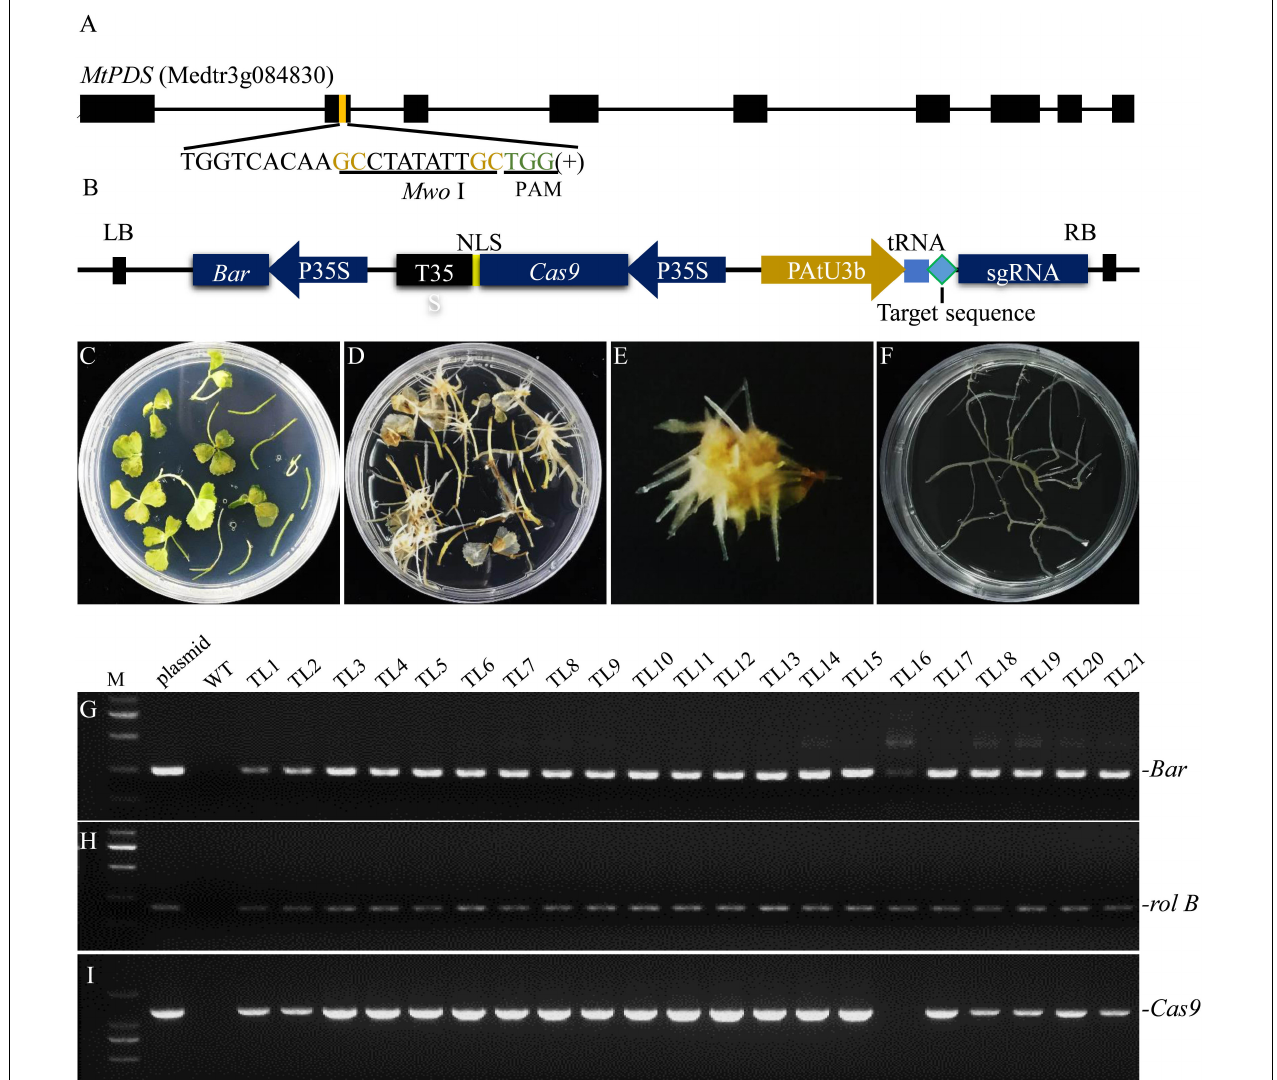
FIGURE 1 | Identification of co-transformed hairy root lines of M. truncatula induced by A. rhizogenes strain LBA9402. (A) Schematic of the MtPDS gene and the selected target sequence. The nucleotides in brown font are part of the Mwo I recognition site, and the green font indicates the PAM. (B) Schematic illustration of the modified CRISPR/Cas9 construct used in this study. (C) The infected explants were transferred to selection medium containing 1.5 mg/L PPT. (D) Hairy roots began to appear from the leaf explants after inoculation with LBA9402 for about 10–15 days. (E) Approximately 10–15 hairy root lines were induced from the leaf blade. (F) Each line from the first generation of hairy roots was subcultured on a new plate to allow further growth. (G–J) PCR screening of DNA samples from the first generation. Untransformed wild type roots served as a negative control, and LBA9402 harboring the CRISPR/Cas9 plasmid was used as a positive control. The expected sizes of the bar , Cas9, rolB , and virG bands are indicated. TL, transgenic hairy root